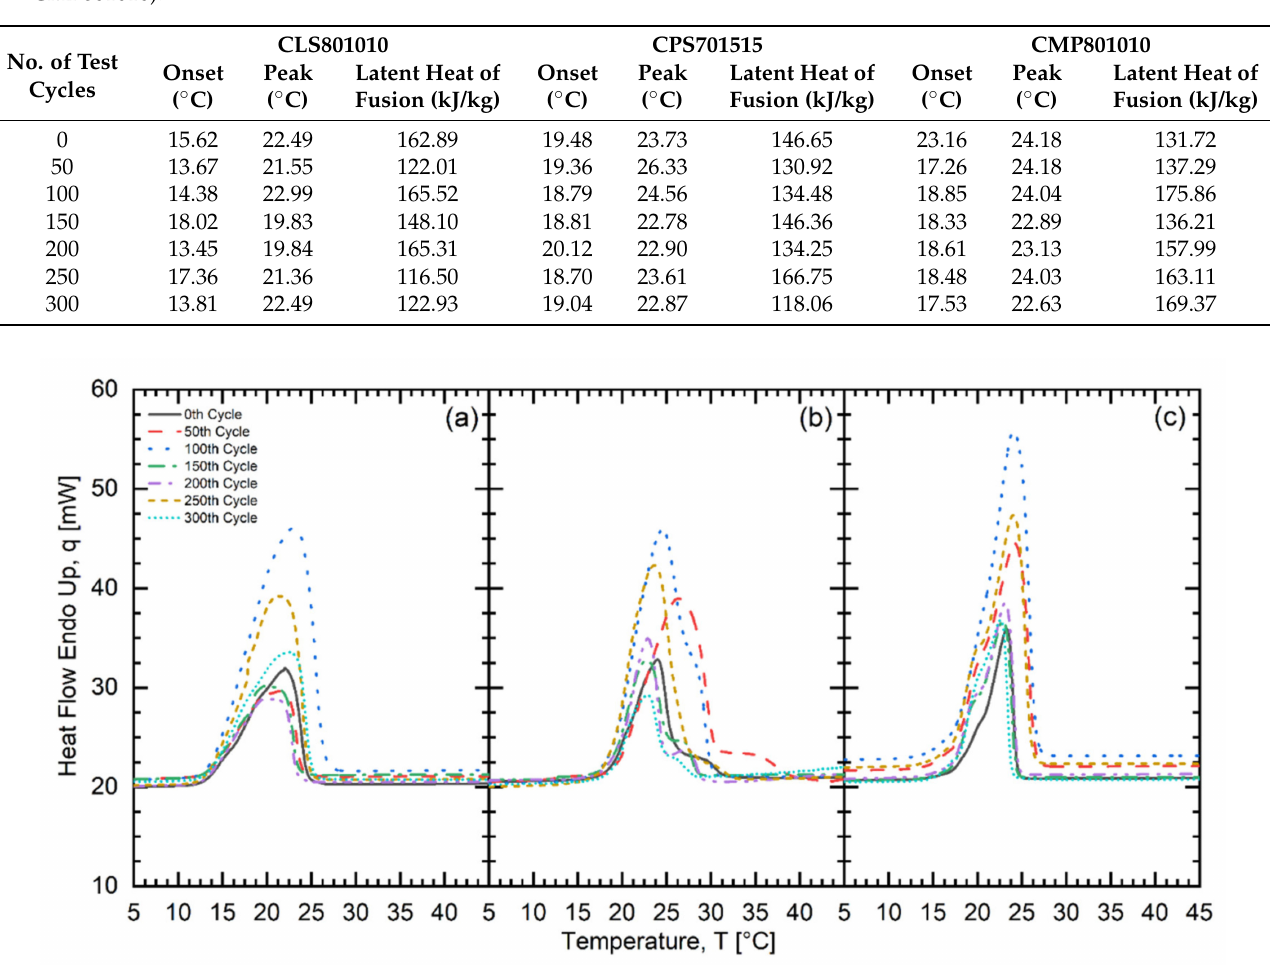
Table 8. Latent heat of fusion and melting temperature of developed materials with test cycles (CLS801010, CPS701515, CMP801010).